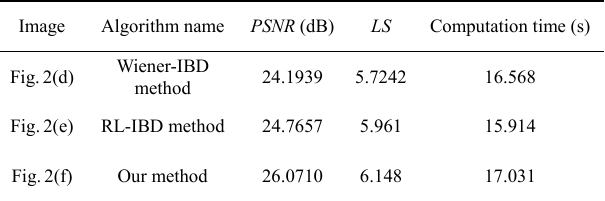
Fig. 3 A line plot taken across the horizontal axis of the three algorithms. Table 2 PSNR , LS , and computation time comparison of the restored stellar AO